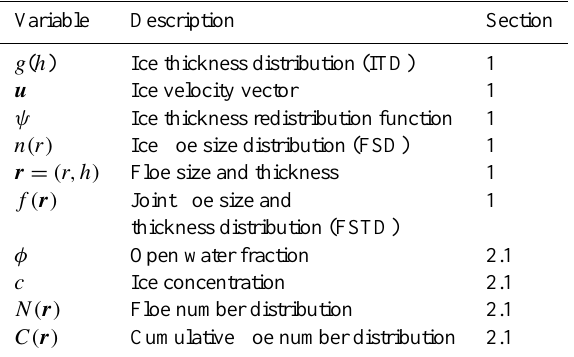
Table 1. Variables appearing in several components of the FSTD